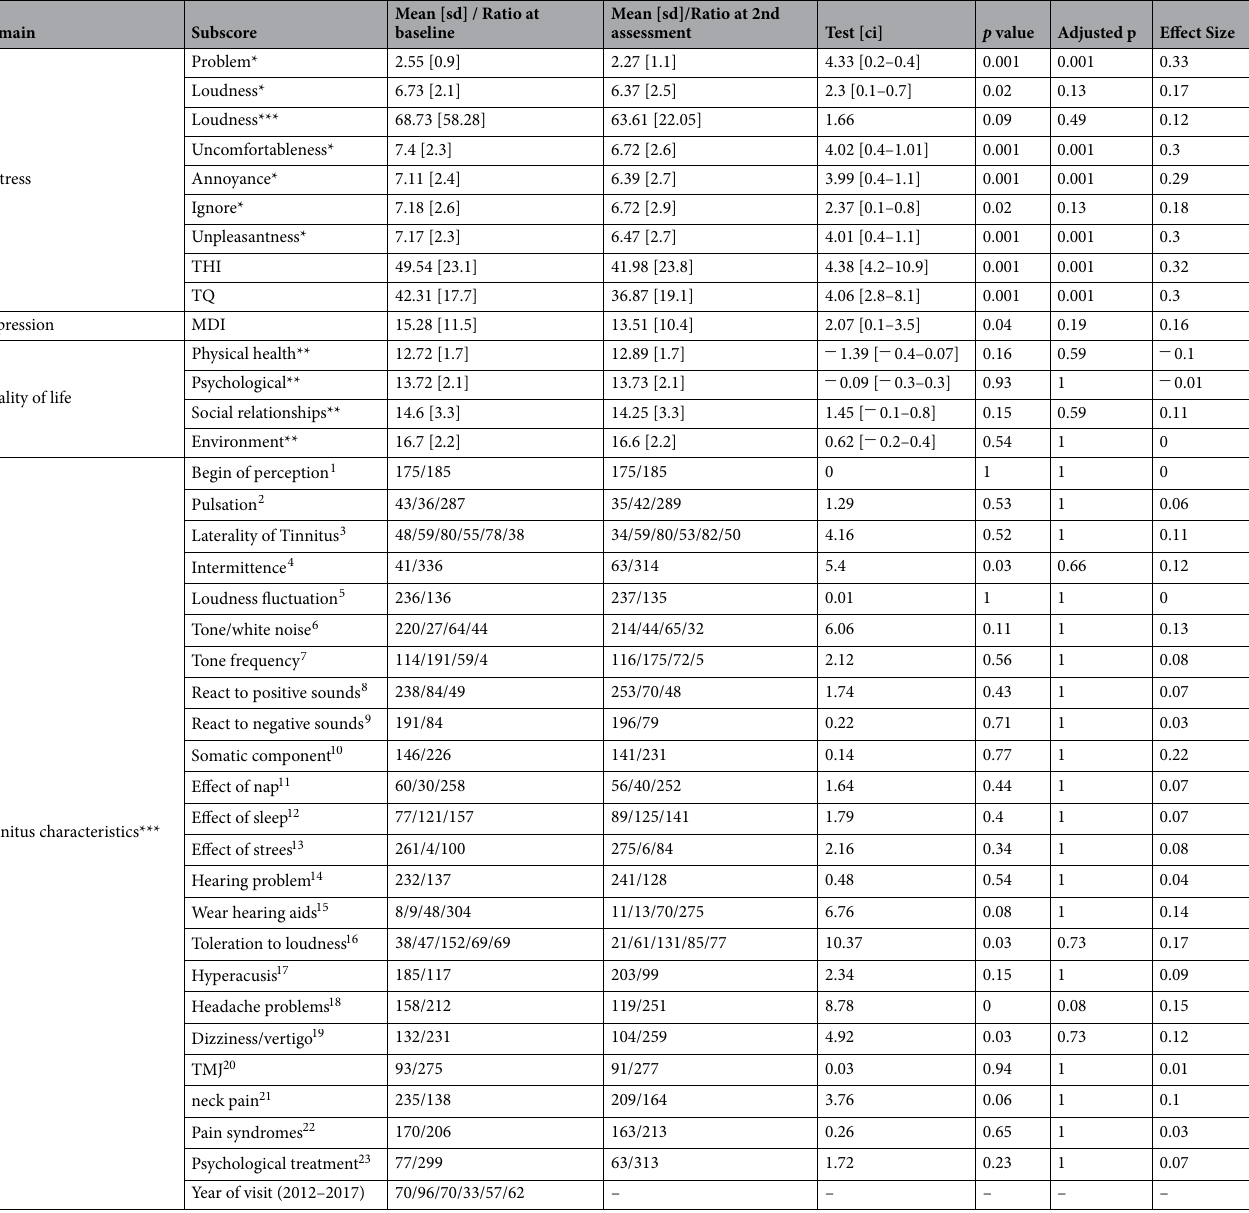
Table 2. Differences between T1 and T2. T-tests and chi-squared tests were used for numeric and categorical items, respectively. The last row shows the frequency of visits per year. Multiple comparisons were corrected with the Holm–Bonferroni method, and effect sizes were calculated with Cohen’s d. Missing observations in pairwise comparisons were excluded from the analysis. * Items of the Tinnitus Numeric Rating Scale; ** Subscores of WHOQoL; *** Items of Tinnitus Sample Case History Questionnaire (TSCHQ). From left to right: 1: gradual/abrupt; 2: yes, with the heart rate/yes, different from heart rate/no; 3: right ear/left ear/ both ears, worse on left/both ears, worse on right/both ears equally/inside the head/elsewhere; 4: intermitent/ constant; 5: fluctuates/constant; 6: tone/noise/cricket/other sound; 7: very high freq./high freq./medium freq./ low freq.; 8: yes/no/do not know; 9: yes/no; 10: yes/no/do not know; 11: worsens tinnitus/improves tinnitus/ no effect; 12: no correlation between sleep and tinnitus/correlation between sleep and tinnitus/do not know; 13: stress influences tinnitus/stress does not influence tinnitus; 14: has hearing problem/does not have hearing problems; 15: right ear/left ear/both ears/none; 16: never/rarely/sometimes/usually/always; 17: suffers from hyperacusis/ does not suffer from hypearcusis; 18: suffers from headaches/does not suffer from headaches; 19: suffers from dizziness/does not suffer from dizziness; 20: suffers from tempomandibular disorders/does not suffer from tempomandibular disorder ; 21: suffers from neck pain/ does not suffer from neck pain; 22: suffers from pain syndrome/does not suffer from pain syndrome; 23: currently having psychological treatment/ currently not having psychological treatment. THI: tinnitus handicap inventory; TQ: tinnitus questionnaire; MDI: major depression inventory; TMJ: transcranial magnetic